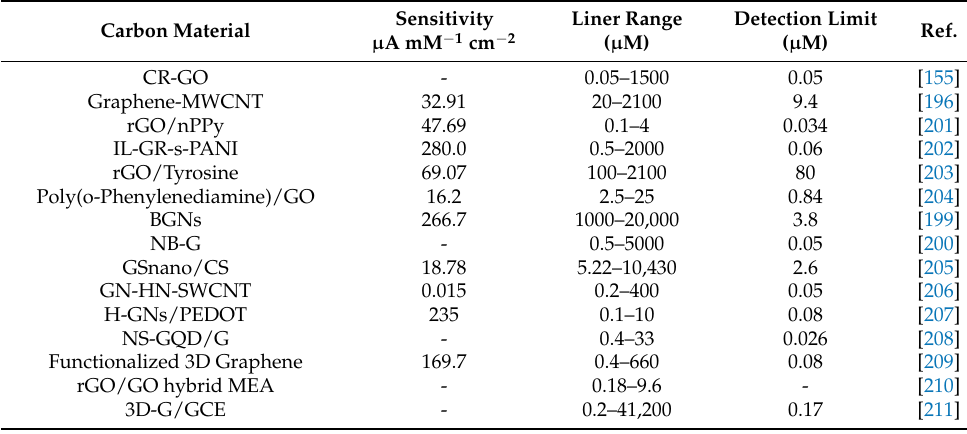
Table 1. Non-enzymatic metal free H 2 O 2 electrochemical sensors based on graphene. Carbon